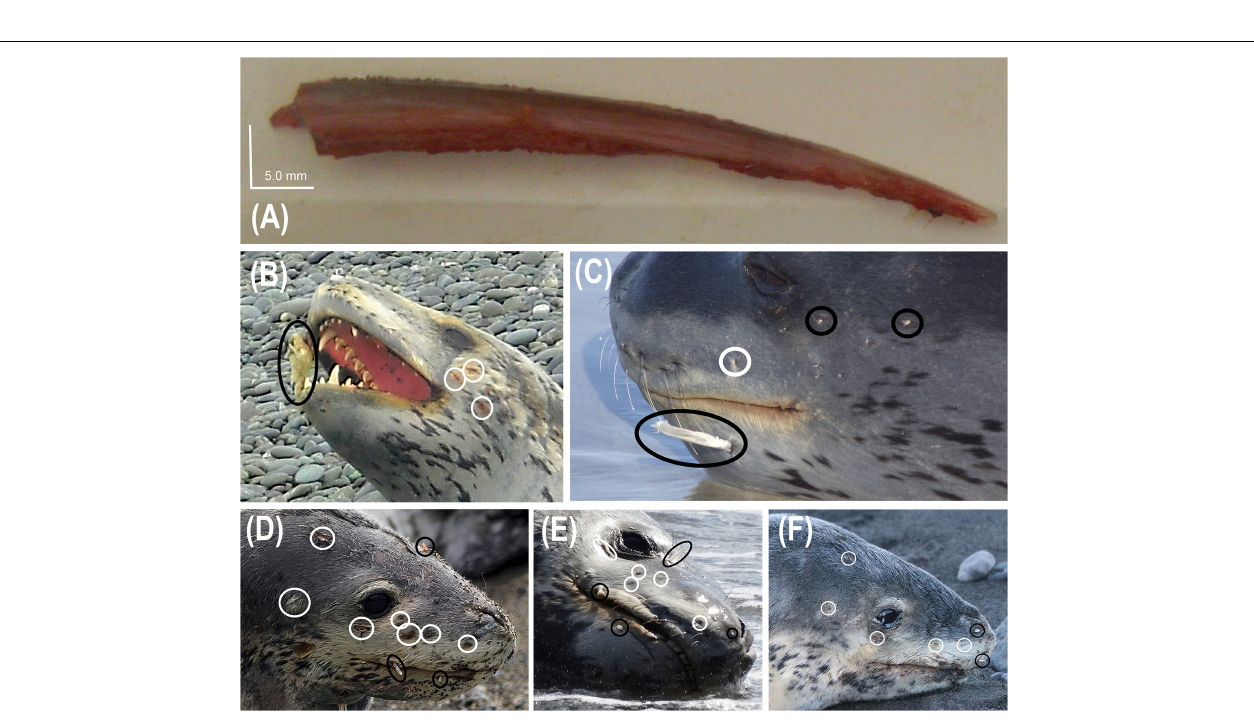
FIGURE 3 | Leopard seal ( Hydrurga leptonyx ) observations of predation in New Zealand, involving embedded dorsal fin spines from unidentified chimaeras (black circles) and puncture wounds (white circles) in the face from unidentified chimaeriforms: (A) dorsal fin spine recovered from deceased adult female HLNZ-P068, last sighted alive on 26 November 2009 at Waikouaiti Beach, Otago, photograph Otago Museum/Department of Conservation; (B) juvenile of unknown sex HLNZ-P043, sighted 15 October 2010, at Birdlings Flat, Canterbury, photograph Anita Spencer; (C) adult male HLNZ-030, sighted 20 September 2015, at Taieri Beach,